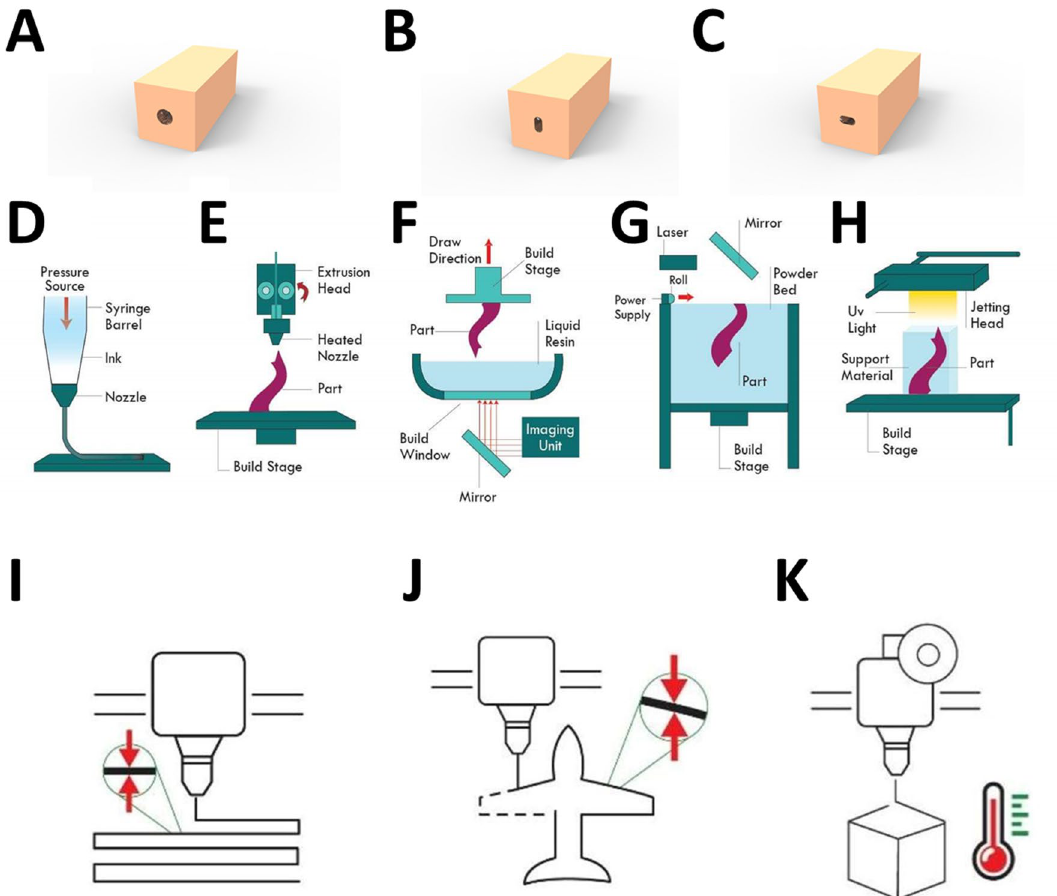
Figure 5. Channels Geometry and additive manufacturing technologies. In ( A ), ( B ) and ( C ) the designed geometries of the channels are shown, taking into consideration that the force is applied from upward direction. While ( D – H ) shows the principle of the most famous 3D printers; direct ink writing, fused deposition modeling, stereolithography, selective laser sintering, and inkjet printing. Finally, an illustration visualizing the parameters optimized is shown for ( I ) layer height, ( J ) line width and ( K ) printing temperature.